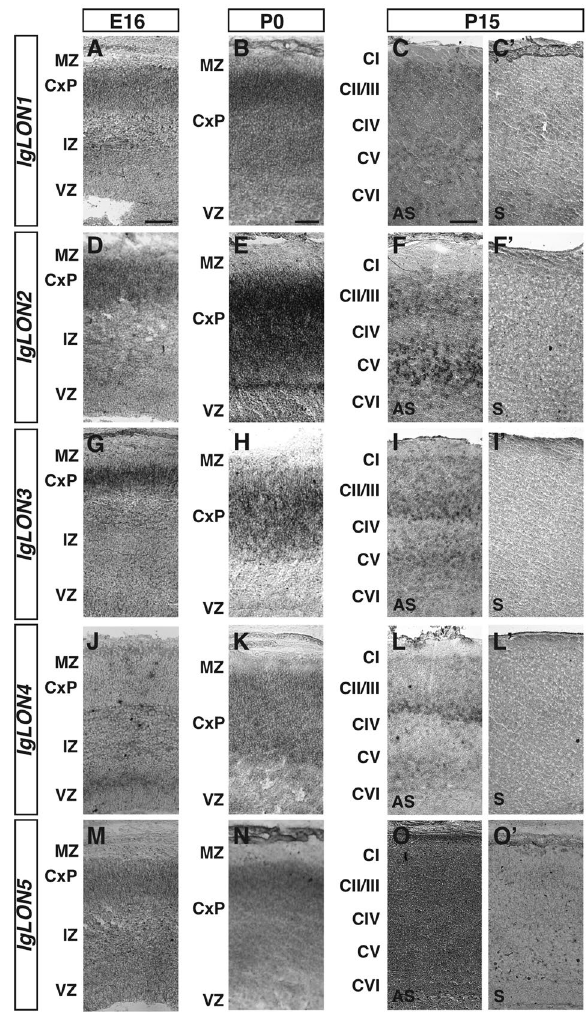
Figure 4. IgLONs mRNA expression during development of the cerebral cortex. In situ hybridization of coronal sections of cerebral cortex from E16, P0, and P15 mice with antisense ( A – O ) or sense ( C ′ – O ′ ) cRNA probes for IgLON genes. IgLON1 was expressed in the cortical plate (CxP) at E16 and P0 ( A , B ). At P15, IgLON1 mRNA was observed in cortical layers II/III (CII/CIII) and V–VI (CV–VI) ( C ). IgLON2 mRNA was detected in the CxP at E16 and upregulated in the CxP at P0 ( D , E ). At P15, IgLON2 is expressed in layers CII/III and CV–VI of the cortex ( F ). IgLON3 expression was detected in the CxP at E16 ( G ) and P0 ( H ), and in layers CII/III and CV-VI at P15 ( I ). IgLON4 mRNA expression is restricted to the apical region of the ventricular zone (VZ) at E16 and at lower levels in the intermediate zone (IZ) ( J ). At P0, IgLON4 expression was detected in the CxP ( K ). Expression at P15 was observed in layers CII/III and CV–VI ( L ). IgLON5 was expressed at low levels in the CxP at E16 and P0 ( M , N ). At P15, IgLON5 mRNA was observed at low levels throughout the cortex ( O ). Scale bars = 125